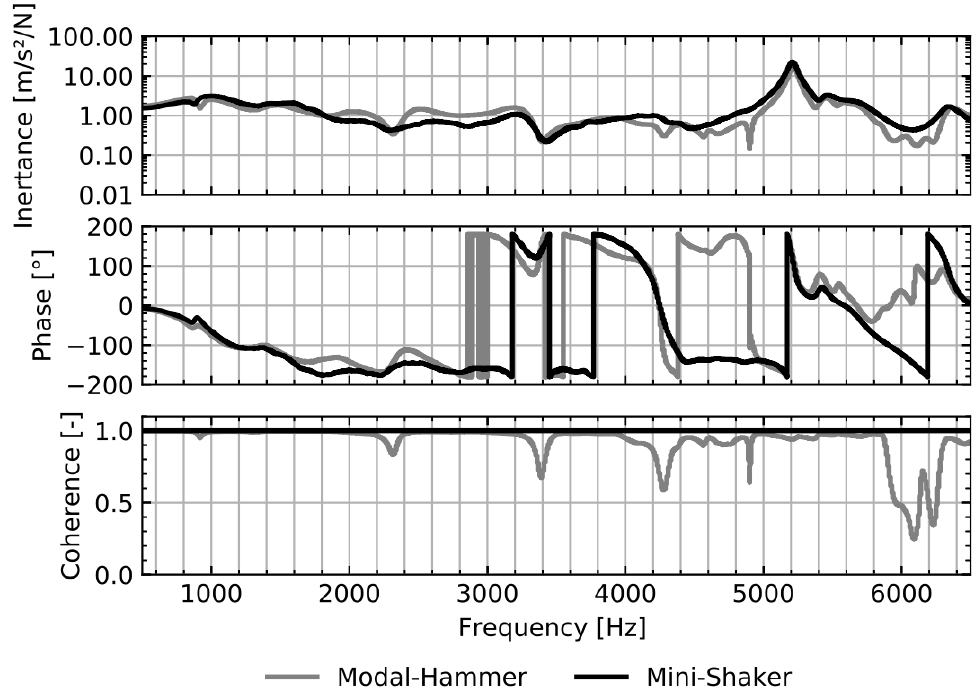
Figure 6. Inertance, phase, and coherence of the hammer and shaker excitation at 0° position in axial reaction direction.